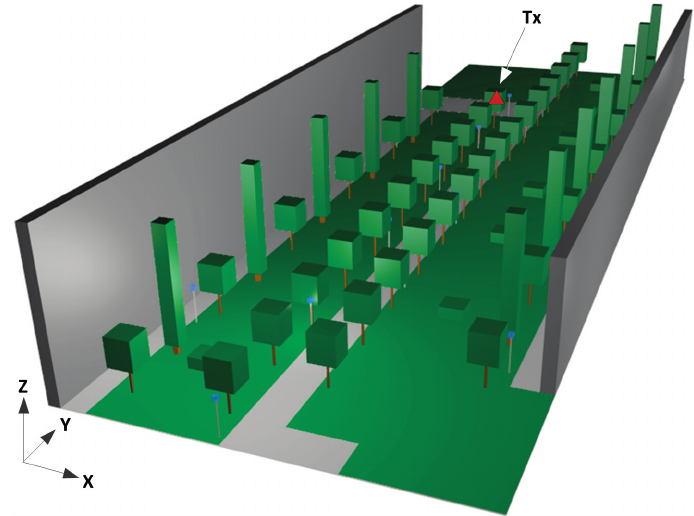
Figure 4. Schematic vegetation environment for simulation in the 3D Ray Launching algorithm.